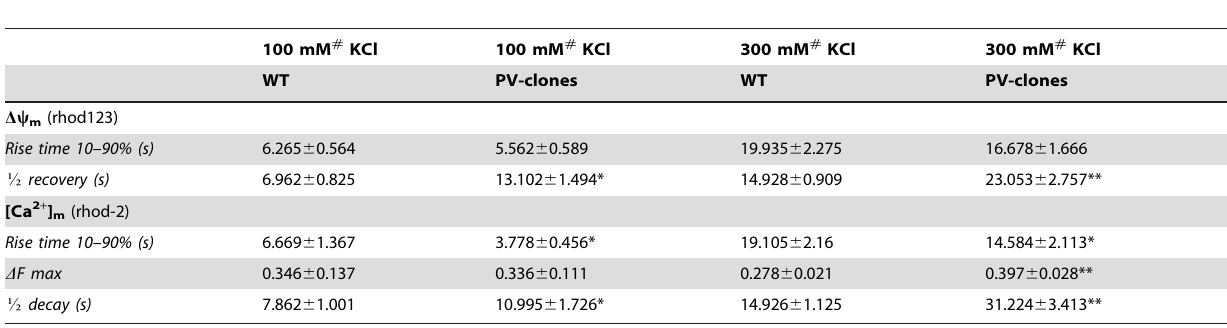
Table 2. Quantitative analysis of the kinetics of intramitochondrial membrane potential ( DY m ) and mitochondrial [Ca 2 + ] m changes in C2C12 WT and PV-clones after KCl-induced